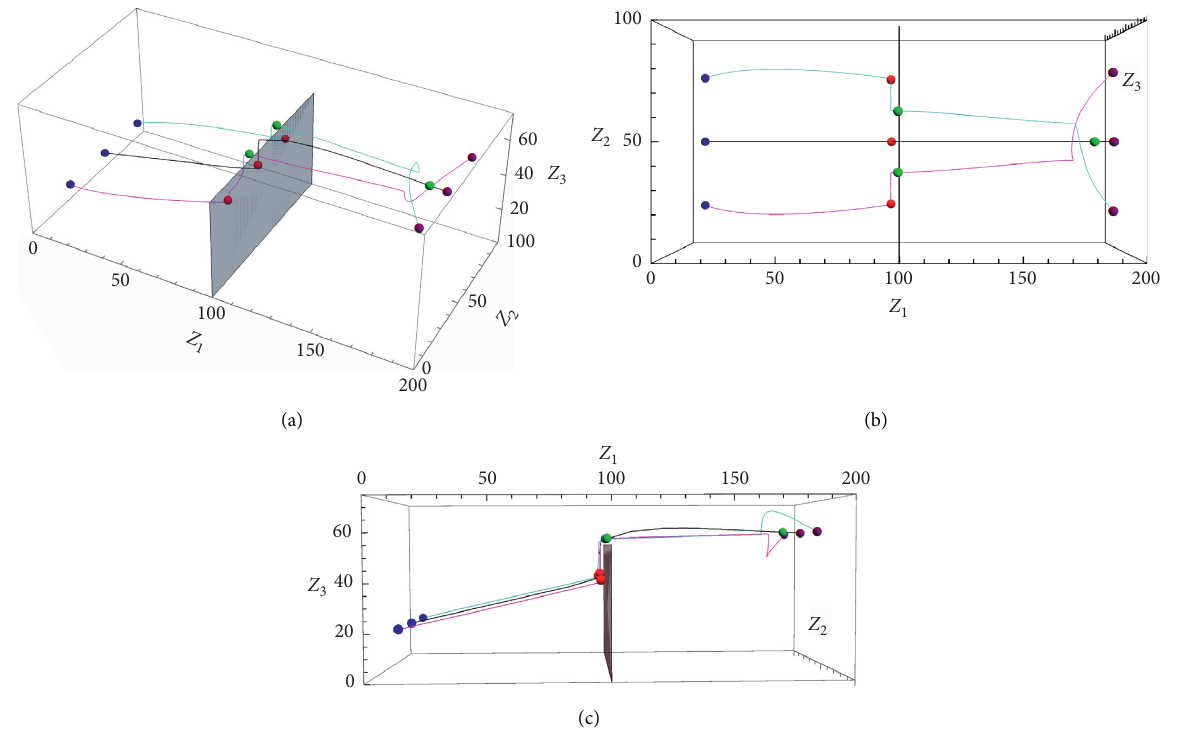
Figure 7: Scenario 1. The different viewpoints of P i while it is in motion to its target with one rectangular-plane obstacle. (a) Default 3D motion view. (b) Top 3D motion view. (c) Front 3D motion view. Table 1: Scenario 1. The parameters utilised in the numerical simulation. There are 3 point-mass mobile robots ( n � 3 ) and 1 rectangular- plane obstacle ( m � t 1 )